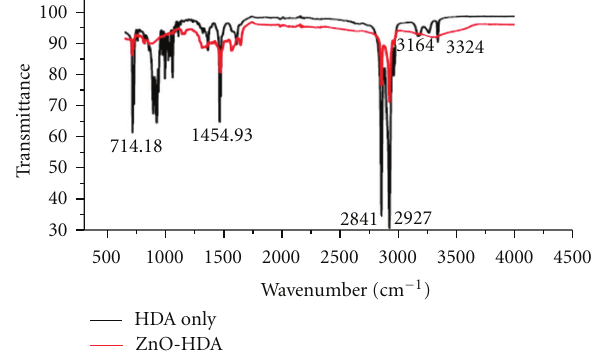
Figure 3: FTIR spectra of ZnO nanoparticles synthesised using zinc nitrate in water at 120 ◦ C and time of 15 minutes under microwave.